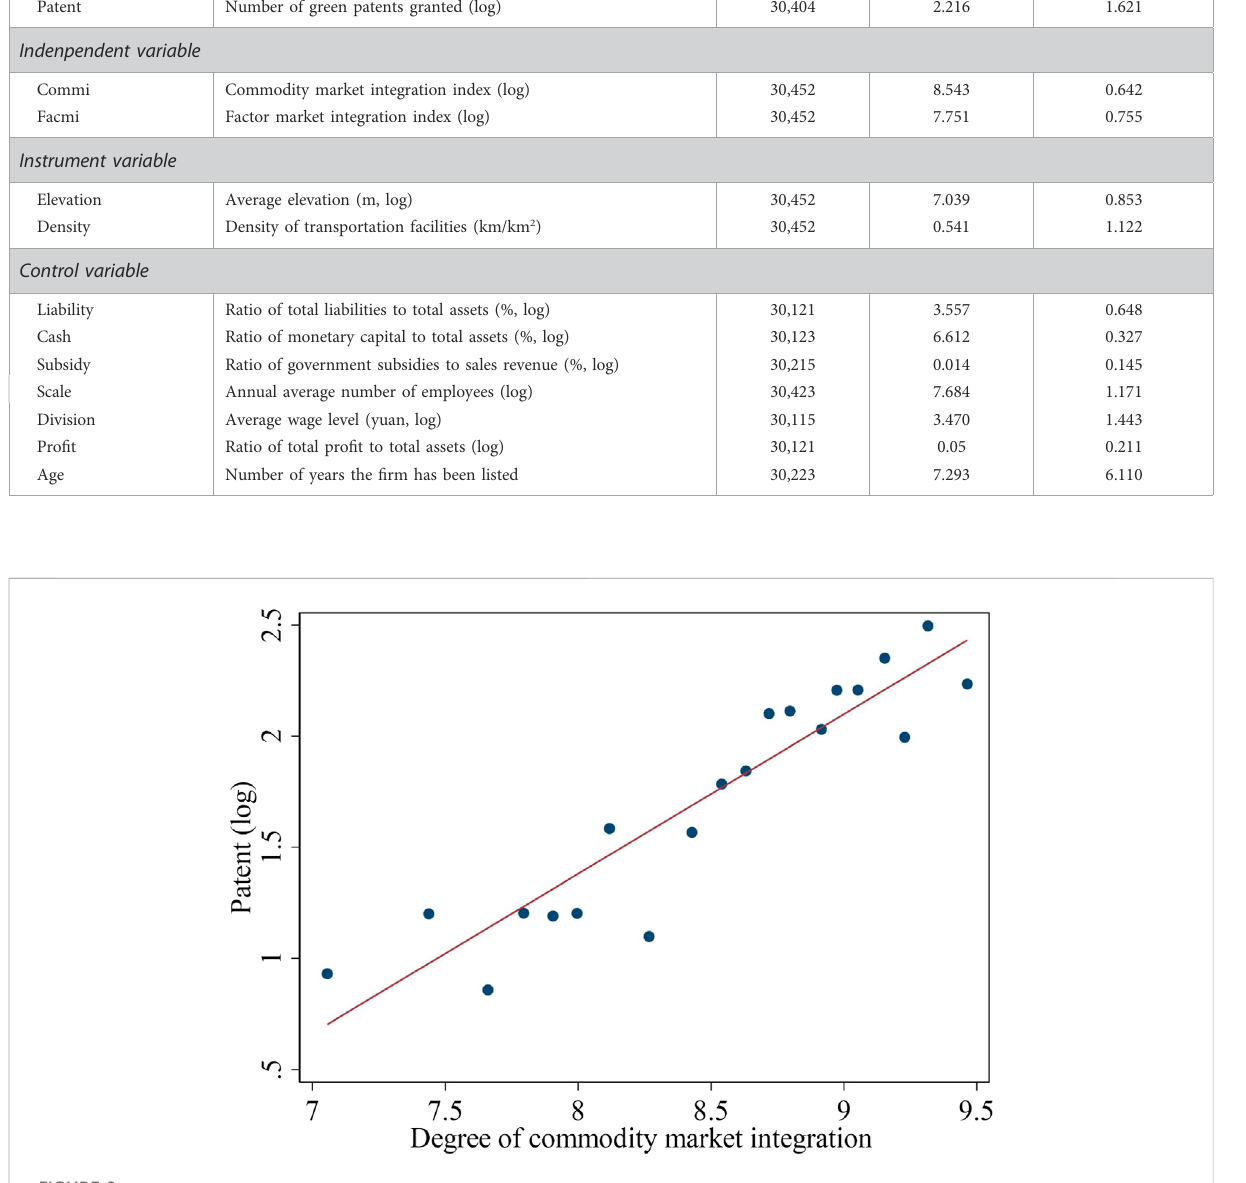
FIGURE 2 Correlation between commodity market integration and green